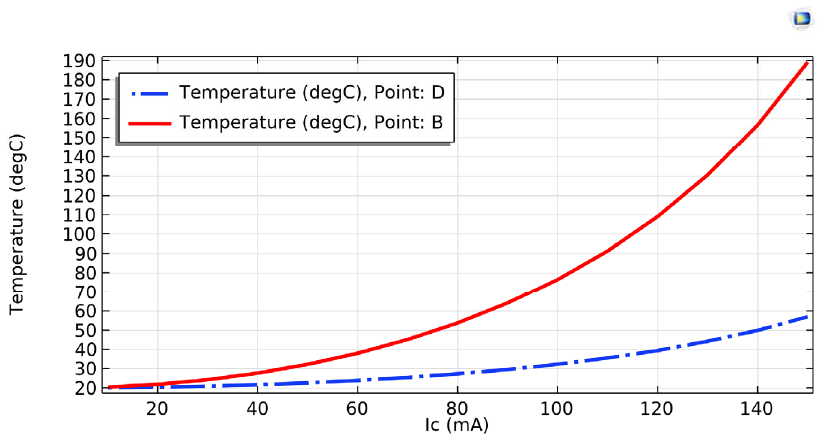
Figure 12. Temperature at points B and D as function of input current (Ic).